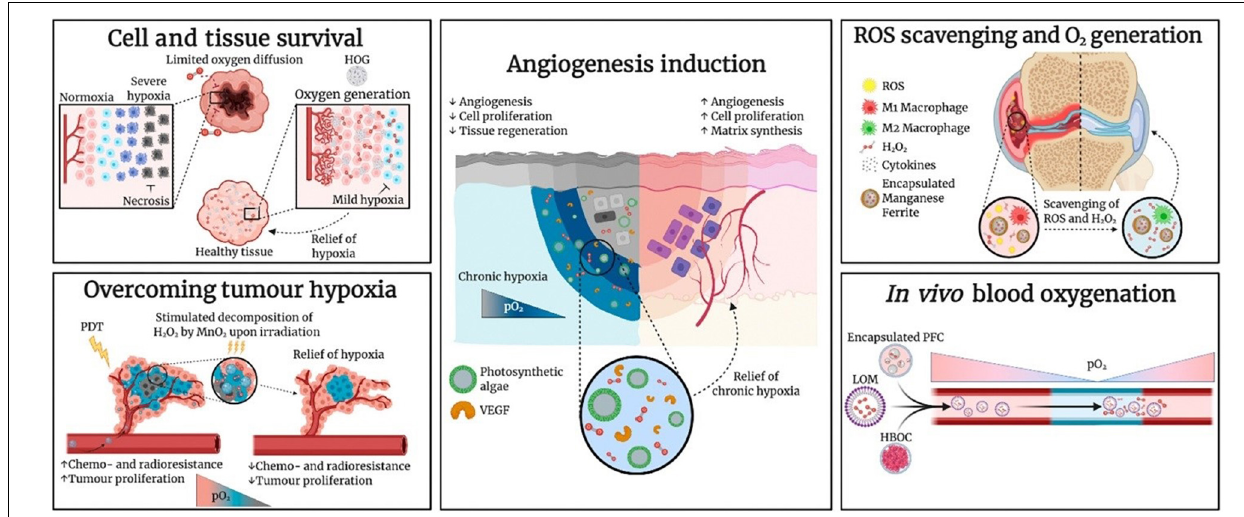
FIGURE 3 | Research Applications of Oxygen-Carrying and Oxygen-Generating Biomaterials (OCBs and OGBs) include the microalgae. Hemoglobin-based oxygen carrier (HBOC), hydrophobic oxygen generator (HOG), lipid-based oxygen microbubble (LOM), photodynamic therapy (PDT), perfluorocarbon (PFC), partial pressure of oxygen (pO 2 ), and vascular endothelial growth factor (VEGF) (31) (Copyright permission: 5179181247874).